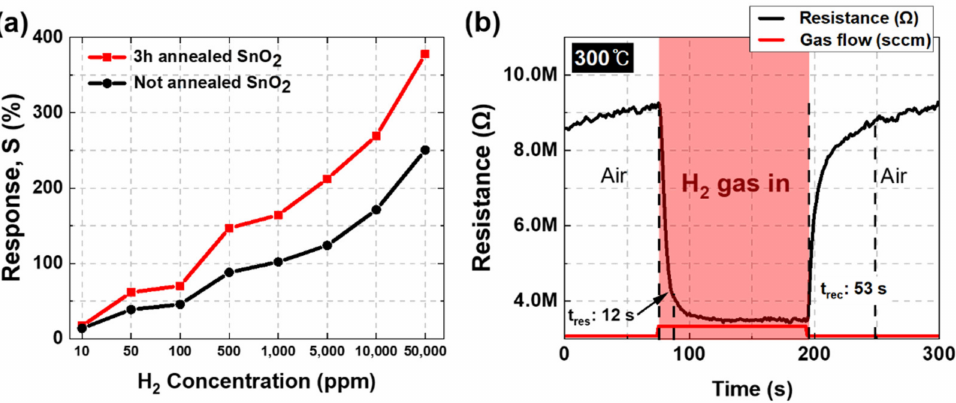
Figure 5. ( a ) Sensitivity of 3-h annealed SnO 2 and not annealed SnO 2 by H 2 concentration; ( b ) hydro- gen response and recovery time of 3-h annealed SnO 2